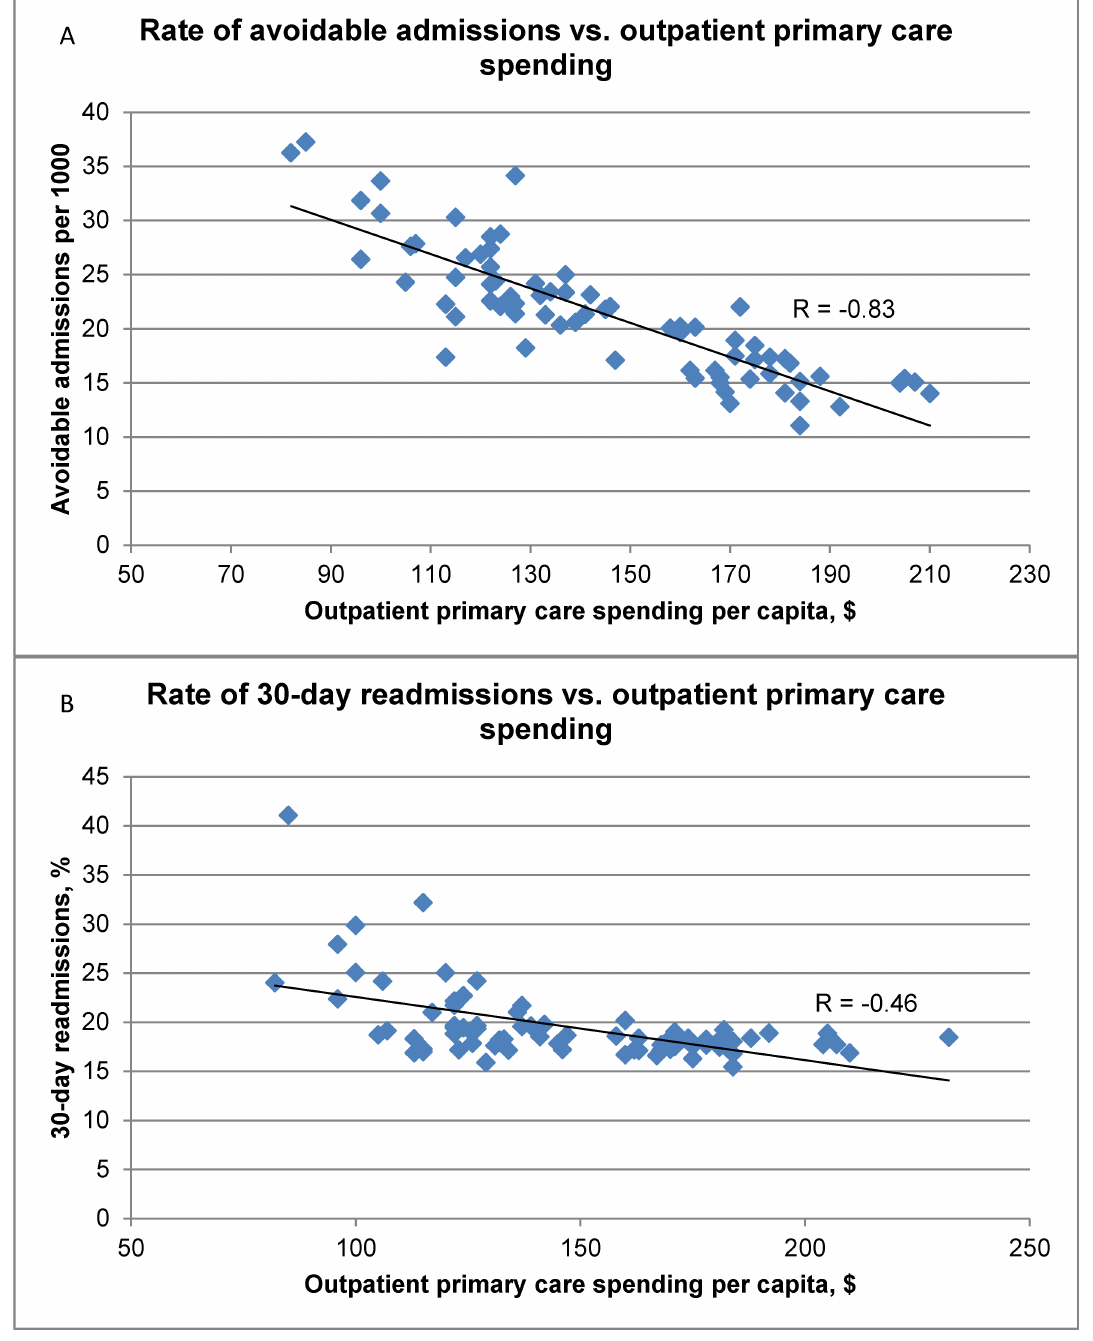
Fig 2. Rates of avoidable admissions per 1000 patients and 30-day readmissions (%) vs. outpatient primary care spending per capita. Rates of avoidable admissions and 30-day readmissions are fully risk-adjusted across all quality indicators within this domain. Outpatient primary care spending was age-sex